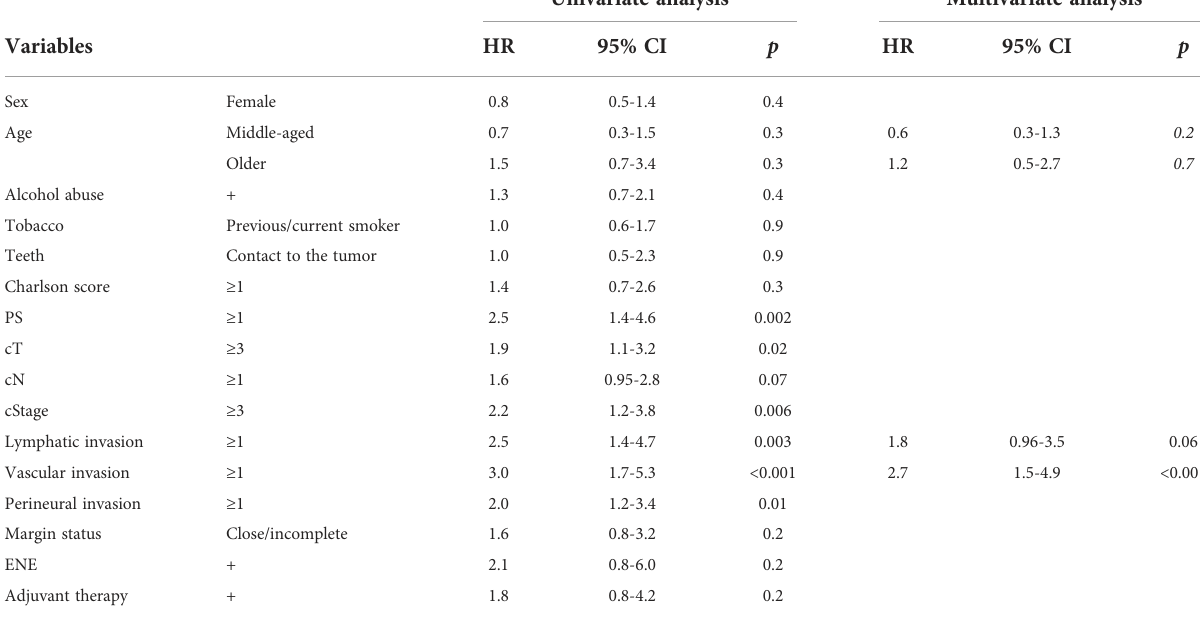
TABLE 3 Univariate and multivariate Cox regression models for OS.